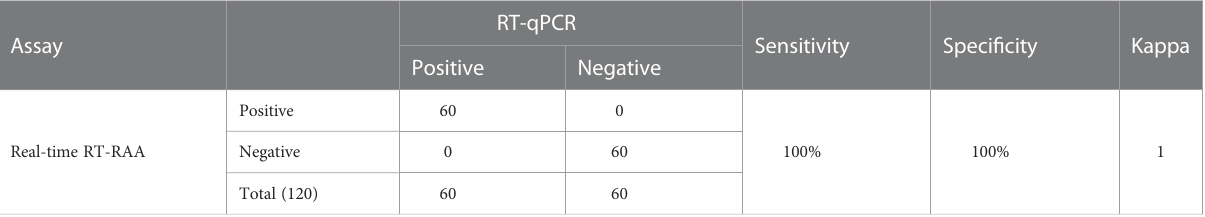
TABLE 2 Comparison of IAVs real-time RT-RAA with RT-qPCR assay on clinical samples.